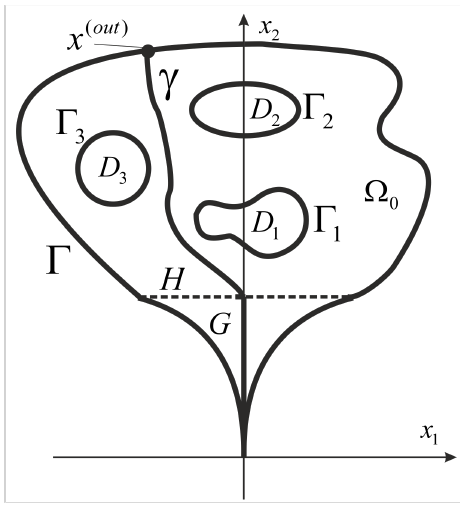
Figure 3. Curve γ